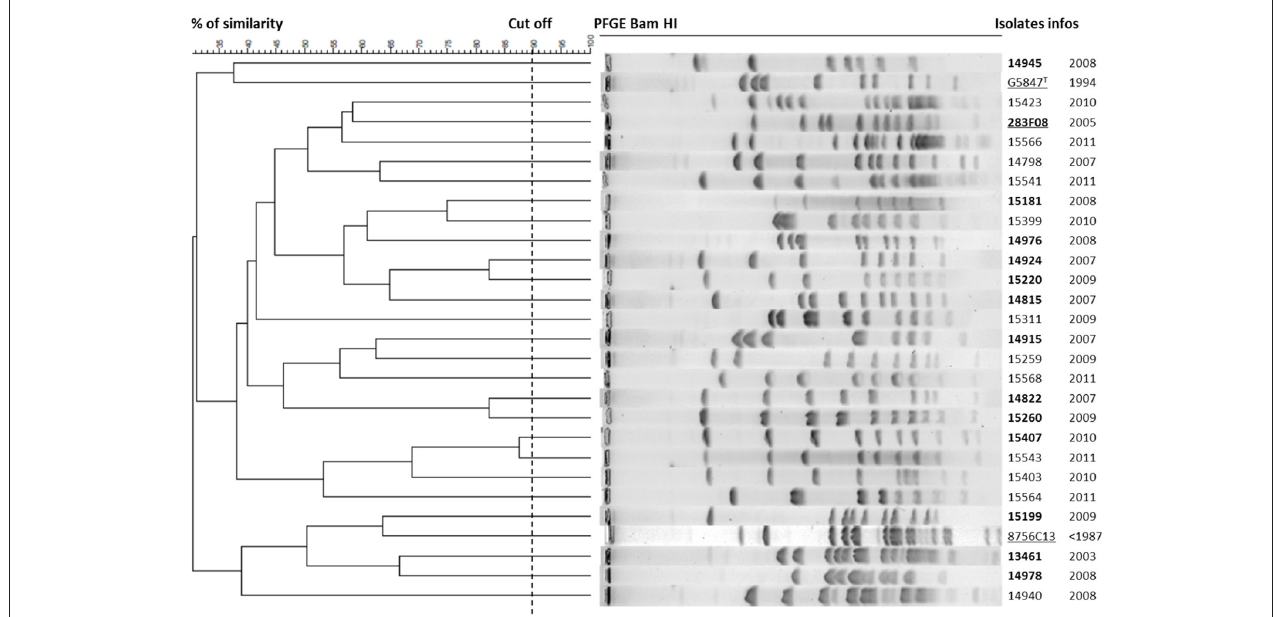
FIGURE 2 | Dendrogram displaying Bam HI-PFGE profiles. Cluster analysis of 28 M. feriruminatoris isolates based on their PFGE- Bam HI profiles using the Dice coefficient and UPGMA. The resulting degree of similarity is indicated on the scale on the left. M. feriruminatoris isolates are characterized by their collection number and year of isolation. Reference strains are underlined and isolates collected from ibex with clinical signs are in bold